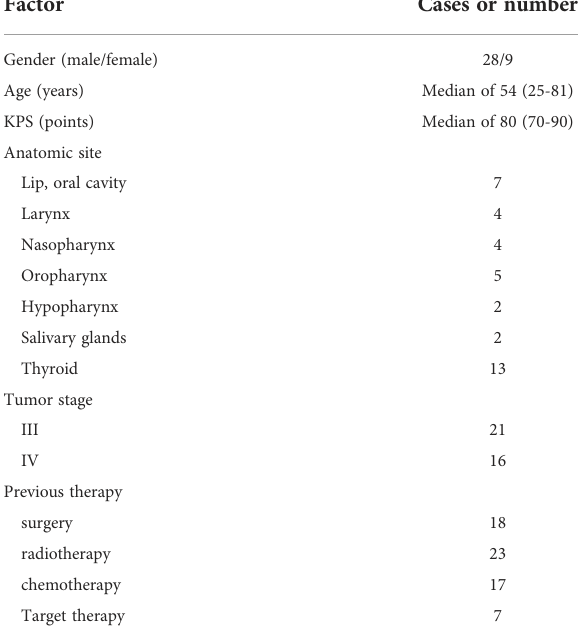
TABLE 1 Basic characteristics of patients in this study. Factor Cases or